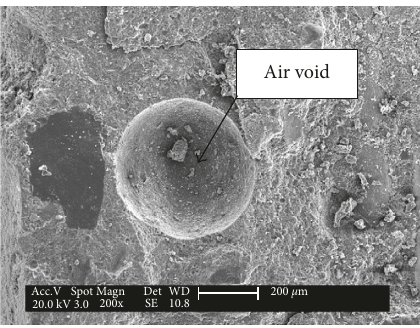
Figure 7: Air void in plain UHPC.